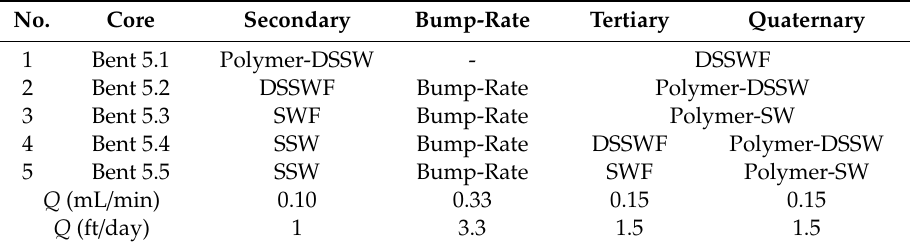
Table 4. Implemented sequence / workflow to perform the core flooding